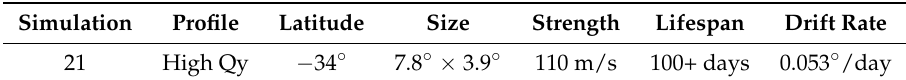
Table 4. Results of cloud